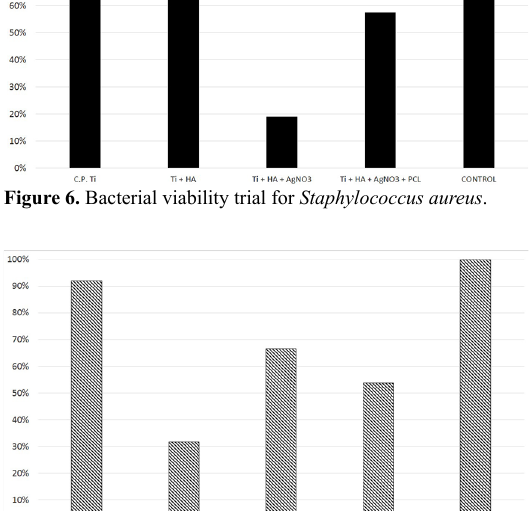
Figure 7. Biofilm formation trial for Staphylococcus aureus